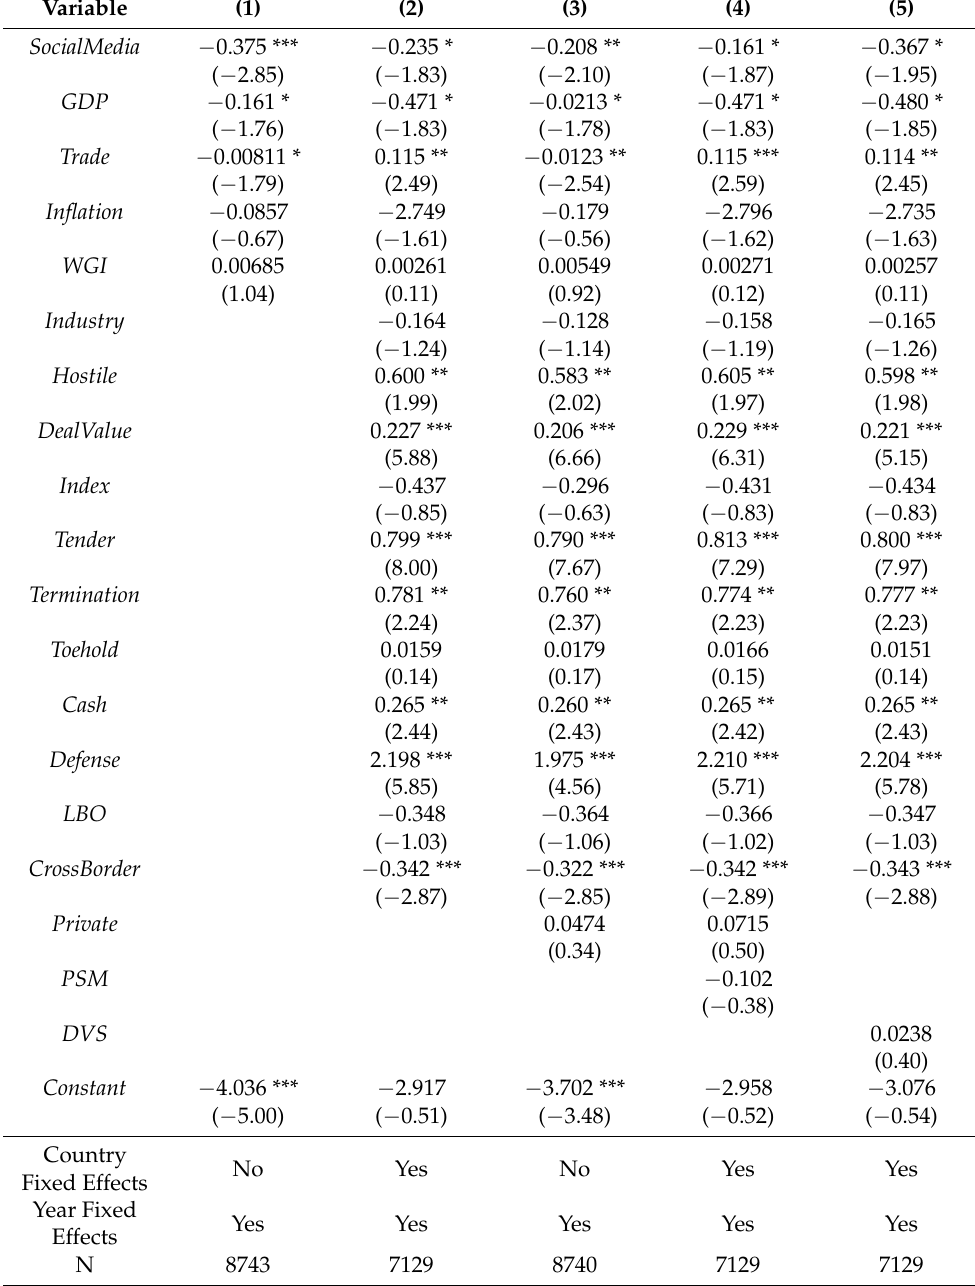
Table 8. Incidence of competing bids for the emerging market subsample. To be included in the subsample, neither the acquiror nor target are domiciled in one of the top ten M&A markets by volume for the full period. This table presents the results of five probit regressions for the subsample of emerging market M&A deals. The dependent variable is Compete, an indicator variable that equals 1 if the deal involved Sa competing bid and 0 otherwise. The independent variable is SocialMedia , an indicator variable that equals 1 if social media is popular in the target country j at time t. Control variables are as described in Table A6 in the Appendix A. Model 1 includes macroeconomic control variables only. Models 2–5 include deal-level variables in addition to macroeconomic control variables. Standard errors are clustered by year in all models. Country and year fixed effects are included in models 2, 3 and